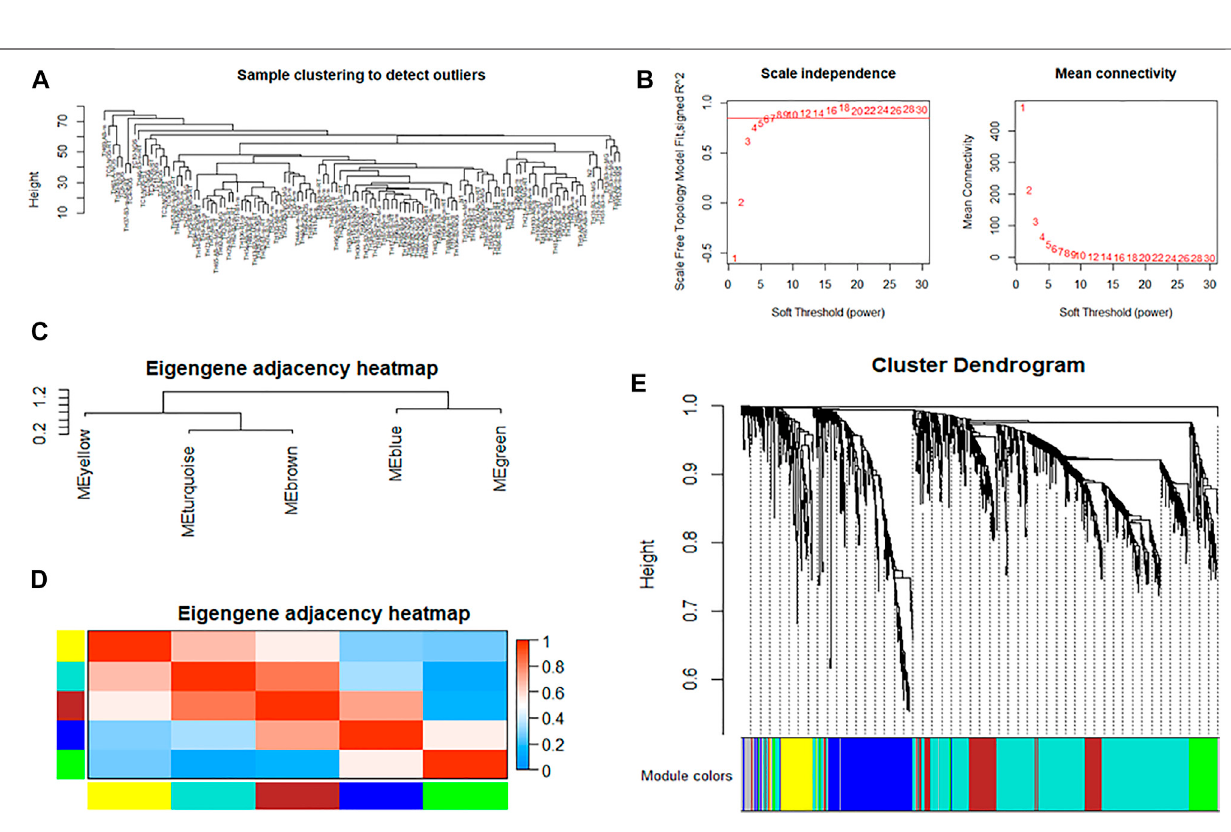
Frontiers in Genetics |